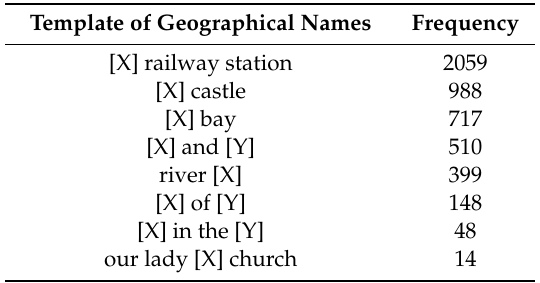
Table 6. Results of template extraction of geographical name (partial). Table 4. Results of template extraction of geographical name